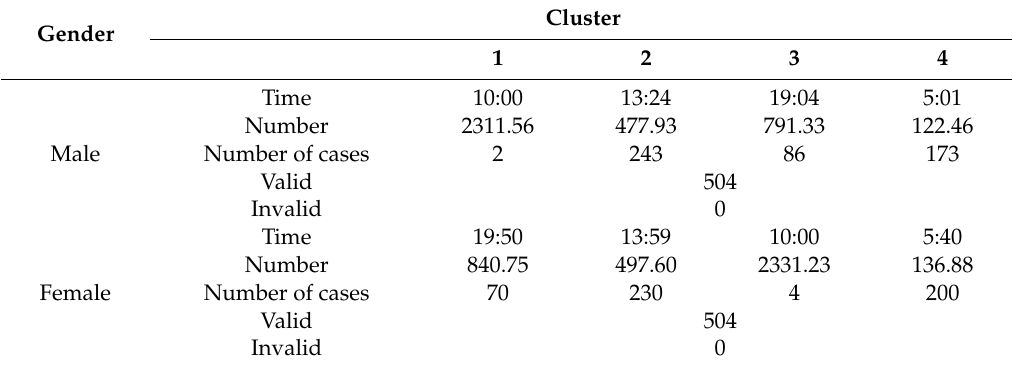
Table 4. Cluster center of check-in points for users of di ff erent